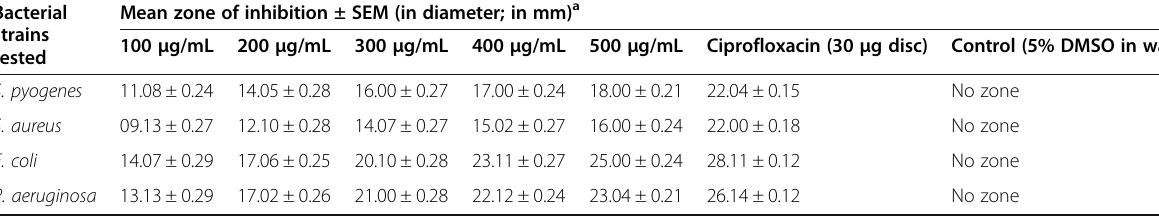
Table 3 Susceptibility of various pathogens to growth inhibition by VNLAC Bacterial Mean zone of inhibition ± SEM (in diameter; in mm) strains tested